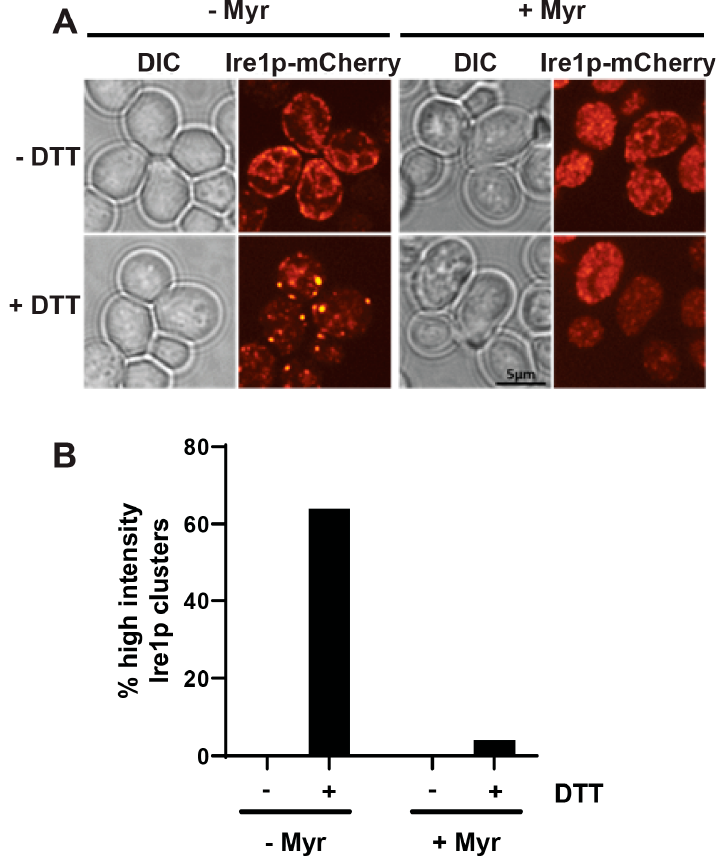
Figure 5. Ire1p clustering is sensitive to sphingolipids. ( A ) Fluorescence microscopy of wt cells expressing Ire1p-mCherry ± 700 ng/mL myriocin. ( B ) Cell counts taken from fluorescence microscopy images of wt cells expressing Ire1-mCherry treated with ± 700 ng/mL myriocin, followed by treatment with ± 5 mM DTT. Proportions of high-intensity clustering cells were measured and at least 150 cells were counted for each condition.